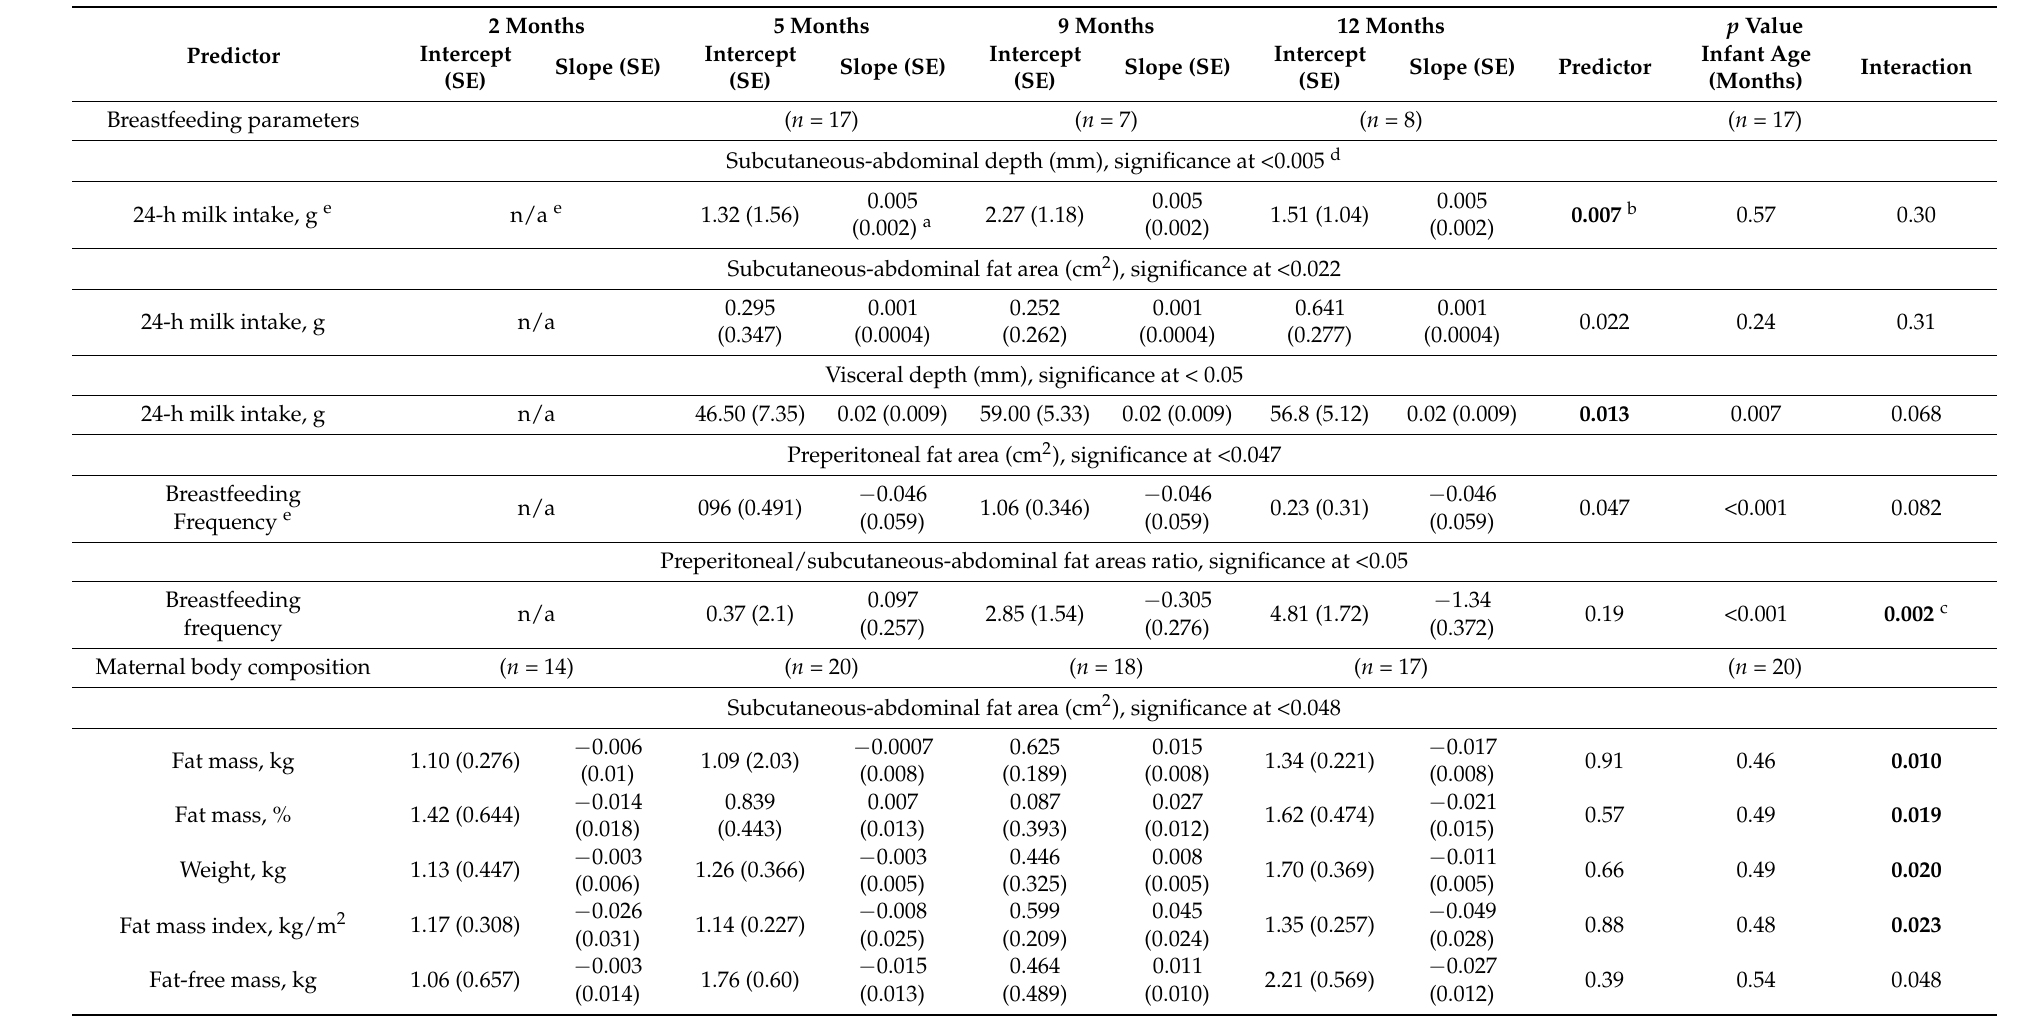
Table 3. Associations between infant abdominal adiposity and breastfeeding parameters and maternal body